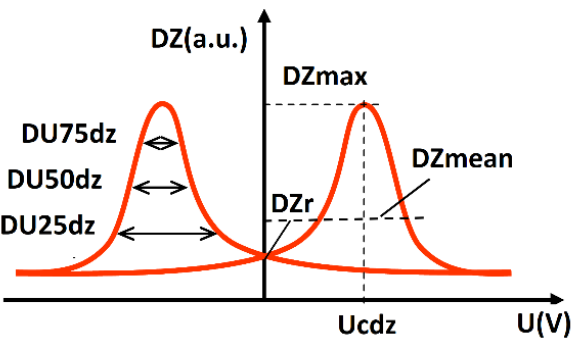
Figure 5. Schematic representation of the incremental permeability curve [4]. Table 2. Subjective features of incremental permeability analysis.